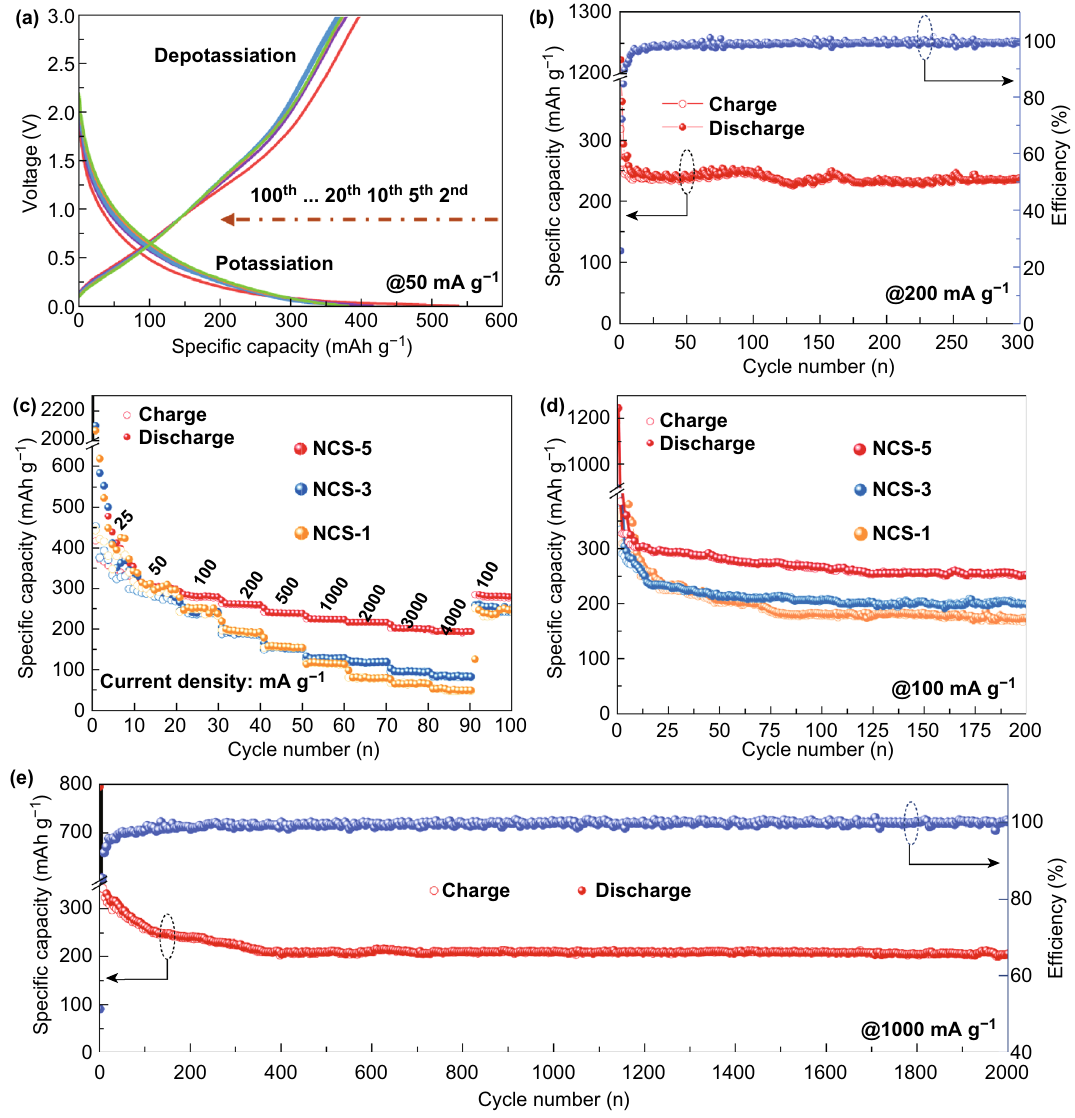
Fig. 4 Electrochemical potassium-ion storage performance of NCSs. ( a ) Profiles of the second, fifth, tenth, 20th, 50th, and 100th potassia- tion and depotassiation cycles of the NCS-5 anode at 50 mA g −1 . ( b ) Potassiation and depotassiation capacity and Coulombic efficiency of the NCS-5 anode at 200 mA g −1 . ( c ) Rate capability of the NCSs anodes at current densities from 25 to 4000 mA g −1 . ( d ) Cycle life of the NCSs anodes measured at 100 mA g −1 . ( e ) Long-term cycling stability and Coulombic efficiency of the NCS-5 anode at 1000 mA g